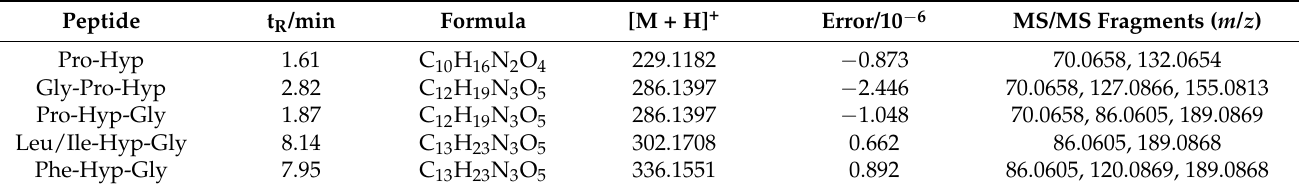
Table 4. The dipeptides and tripeptides in rat plasma after oral ingestion of